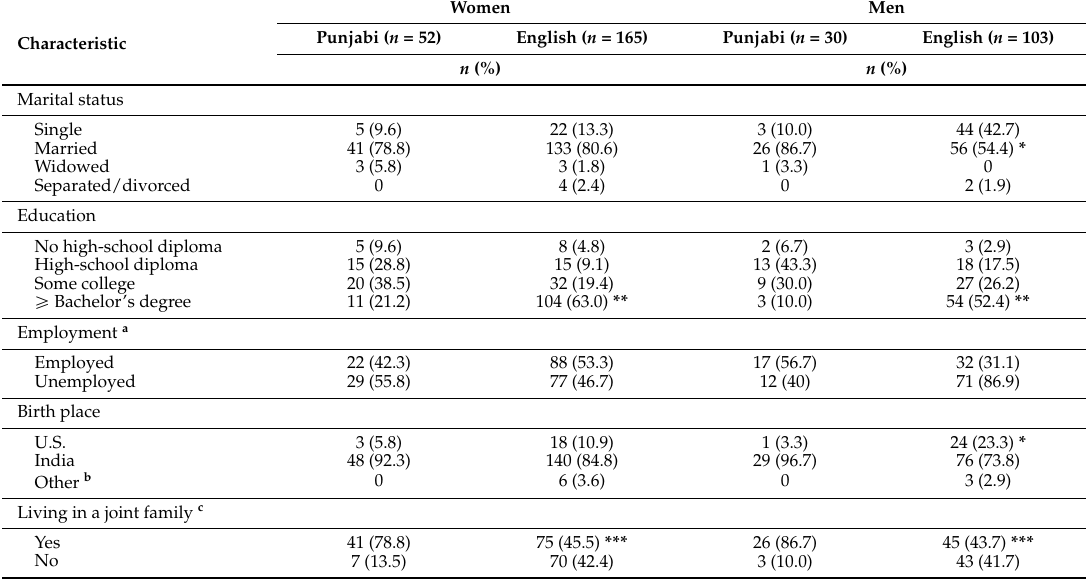
Table 2. Comparing by survey language within gender